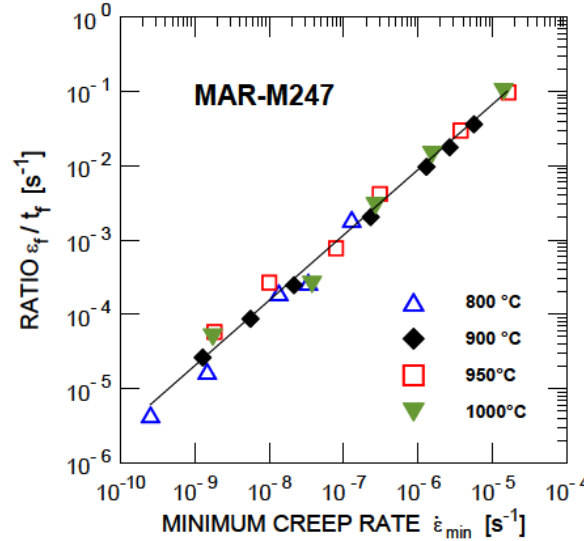
Figure 14: Normalized Monkman-Grant relationship for different temperatures for the G